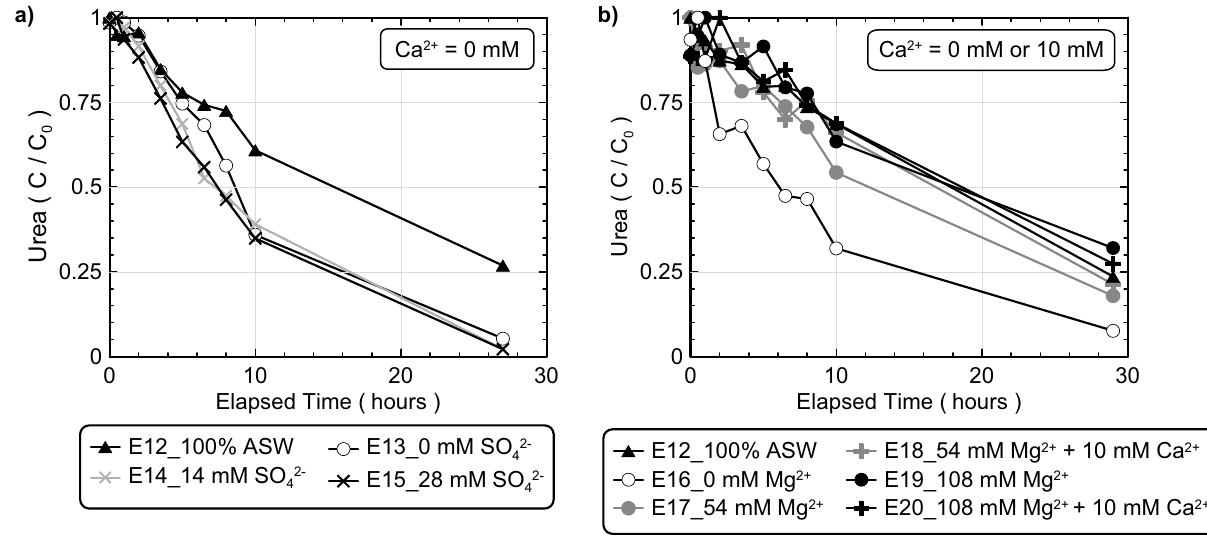
Figure 7. Normalized concentrations of urea in time for experiments with ( a ) varying SO 4 2− and ASW concentrations and no added Ca 2+ and ( b ) varying Mg 2+ and ASW concentrations with minimal added Ca 2+ . All experiments included the addition of 250 mM urea, 0 mM or 10 mM Ca 2+ , S. pasteurii cells at 6.6 × 10 7 cells/mL, and varying SO 4 2− , Mg 2+ , or ASW additions.